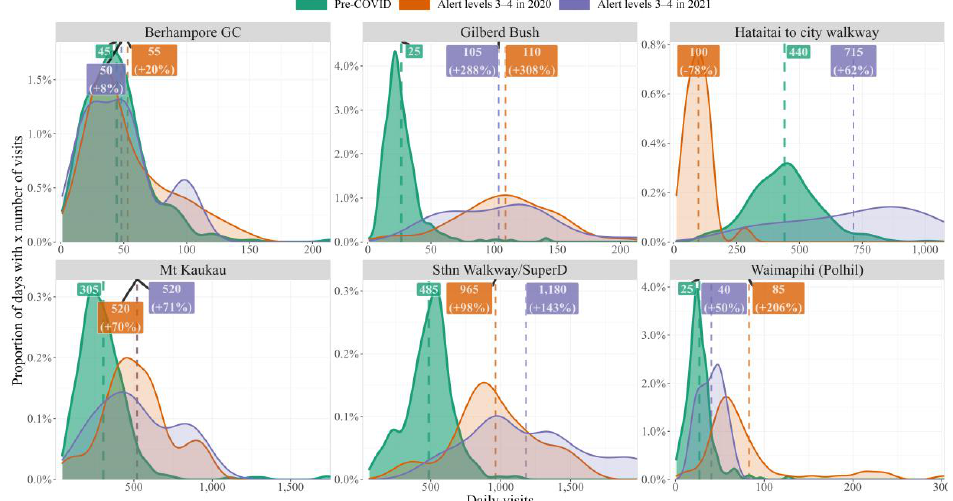
Figure 5. The distribution of daily green space visits during high Alert Levels (3–4) in 2020 (orange) and 2021 (purple) compared to the pre-COVID-19 (2019) periods. The graphs show the proportion of days (y-axis) with a number of daily visitors (x-axis), and thus show how consistent the number of visits is. The mean daily visitors are also marked with a dashed line and label with this compared to 2019. All values have been corrected for mean monthly and weekend/weekday differences.